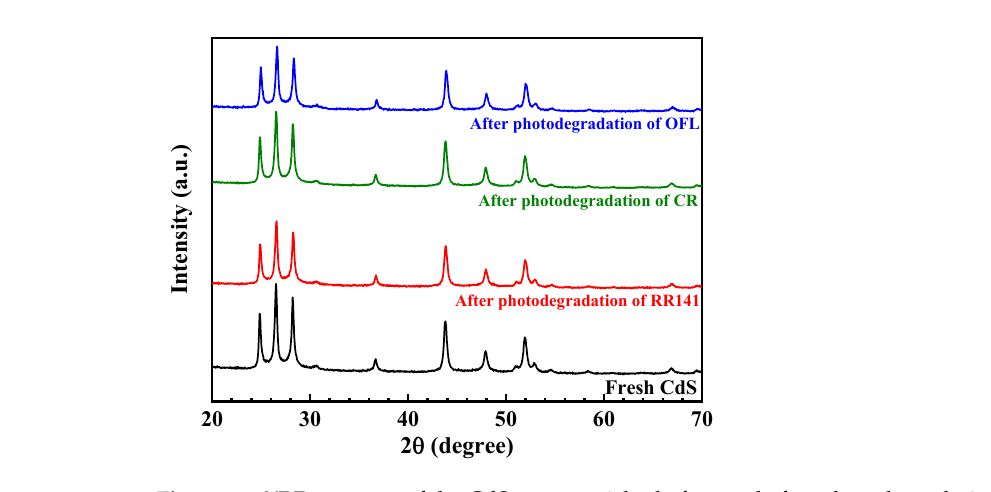
Figure 10. XRD patterns of the CdS nanoparticles before and after photodegradation of RR141, CR dyes, and OFL antibiotic.